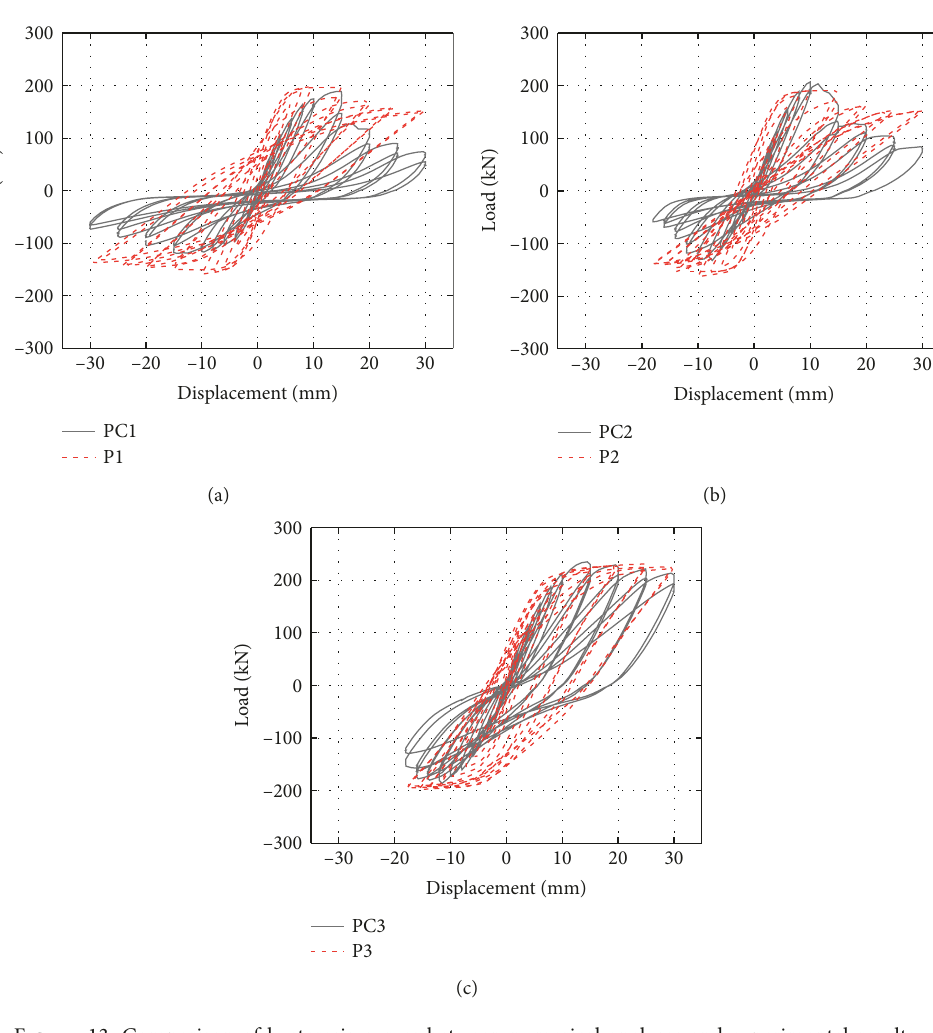
Figure 13: Comparison of hysteresis curves between numerical analyses and experimental results.